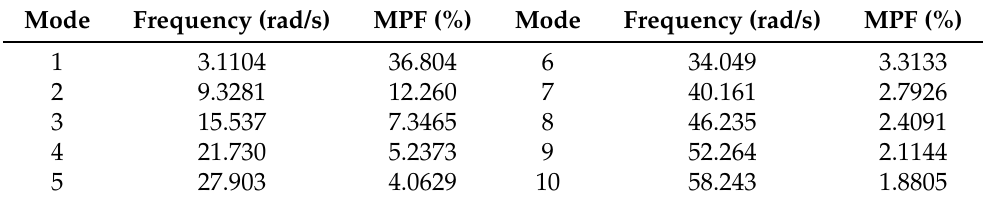
Figure 6. A 50-DOF spring-mass system. Table 5. The first 10 natural frequencies and MPFs of the